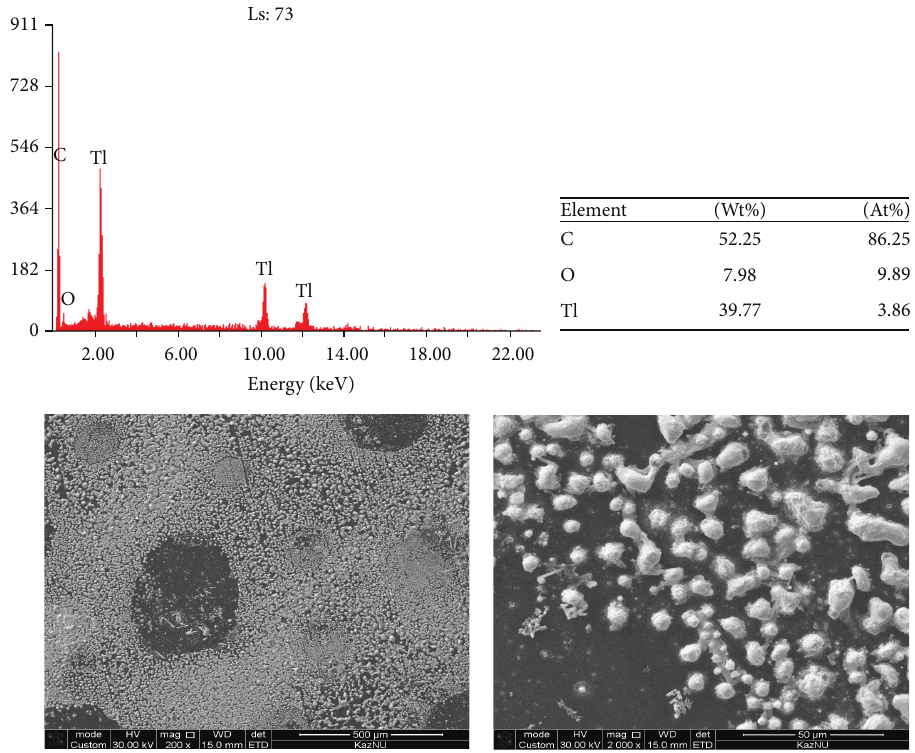
Figure 15: The results of the analysis of the surface of glassy carbon electrode obtained after deposition of thallium at 𝐼 = − 1300 𝜇 A in 0.01 mol/L solution of Tl 2 SO 4 ; background is Na 2 SO 4 , pH = 7 without